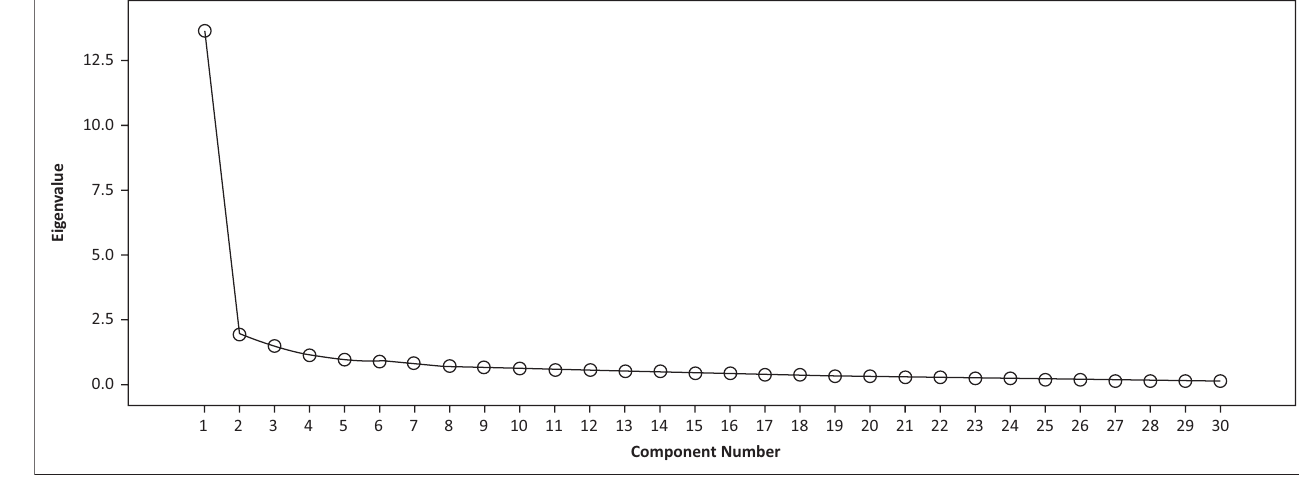
FIGURE 1: Scree plot and extracted eigenvalues suggested a four-factor solution.